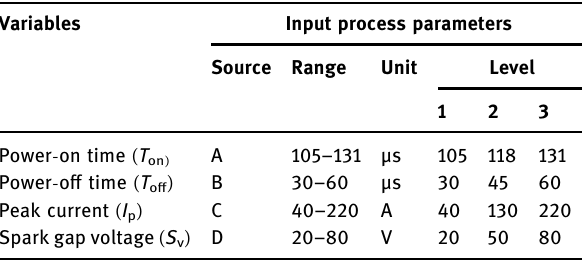
Table 1: Ranges and levels of input variables Variables